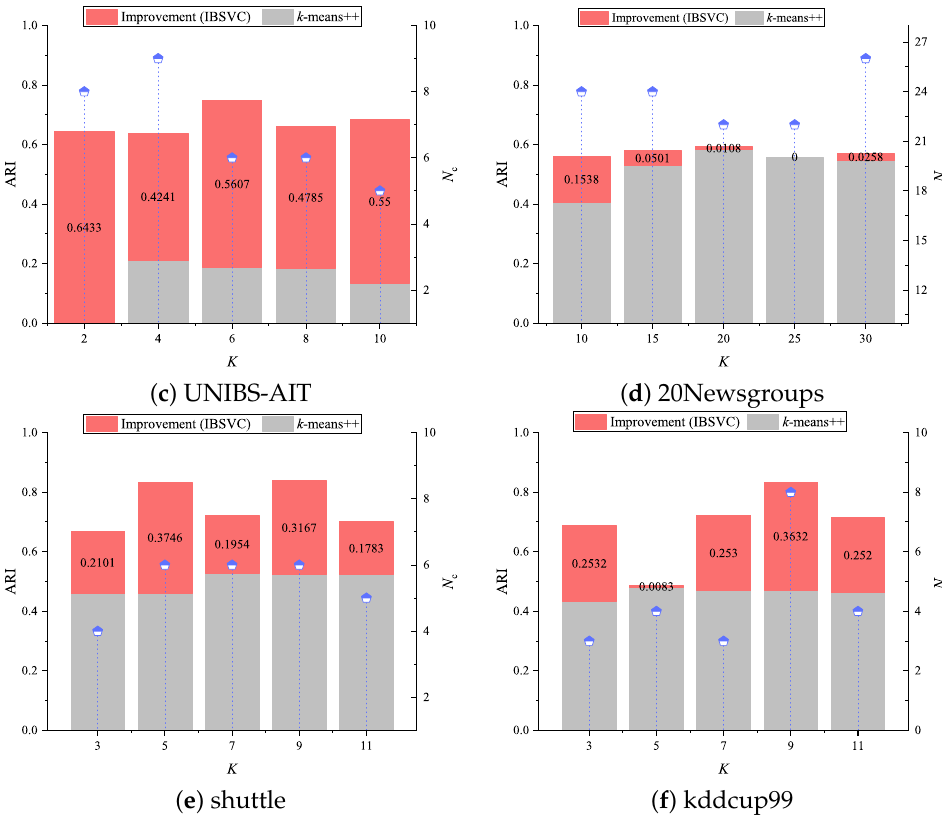
Figure 6. Improvements over k -means++ made by